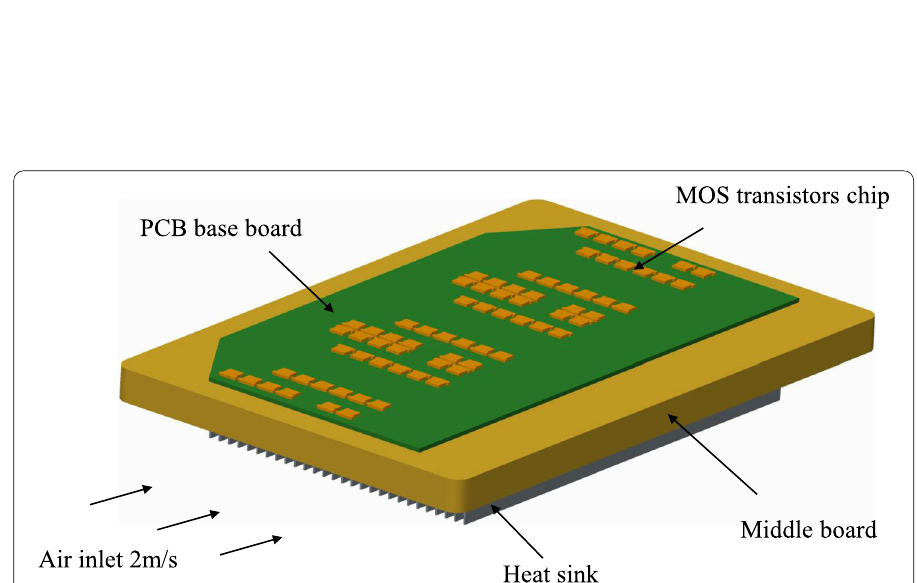
Fig. 4 Overview of the motor